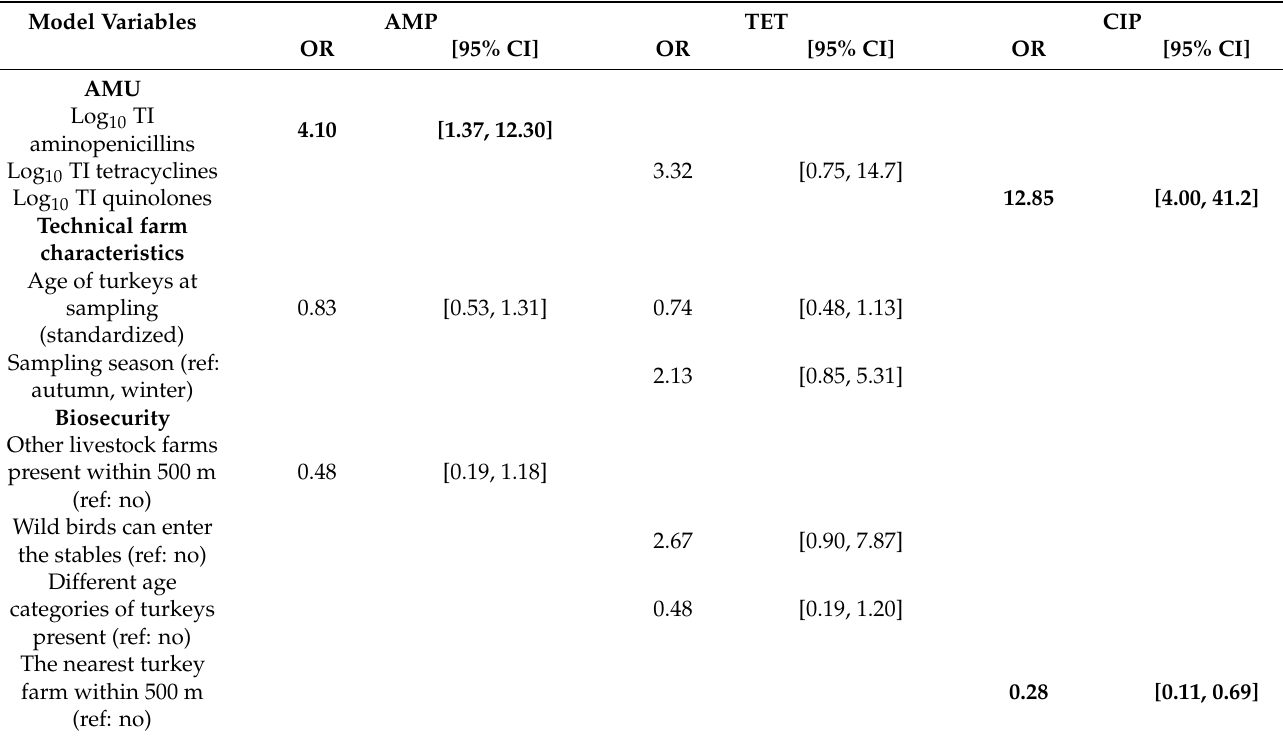
Table 4. Multivariable associations between antimicrobial usage (AMU) and characteristics and biosecurity measures of the turkey farms and the occurrence of E. coli isolates from turkey faeces resistant to ampicillin, tetracycline, and ciprofloxacin. Model